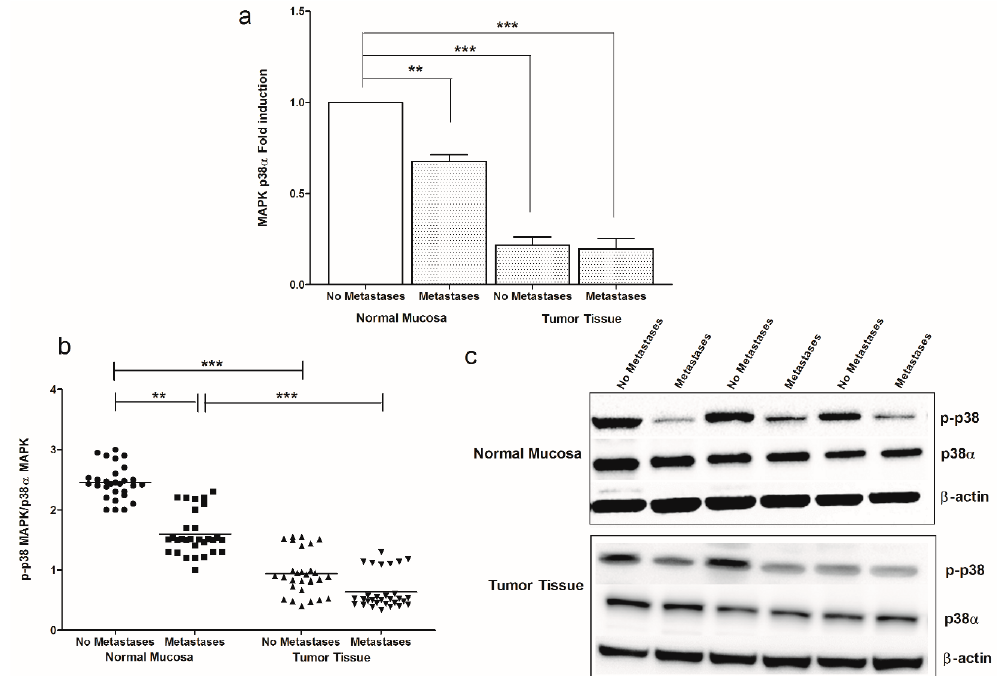
Figure 2. ( a ) MAPK p38 α gene expression levels in intestinal tissue of no metastases ( n = 29 patients) and with metastases patients ( n = 30 patients) detected in both normal mucosa and tumor tissue. Data, expressed as mean value ± SD, are presented as fold induction, compared to normal mucosa of patients without metastases. ( b ) Dot plots graph of p-p38 MAPK / p38 α MAPK ratio protein values detected in our patients groups. ** p < 0.02, *** p < 0.001 indicate statistically significant di ff erences ( c ) Representative Western blot bands of p-p38, p38 α and β -actin